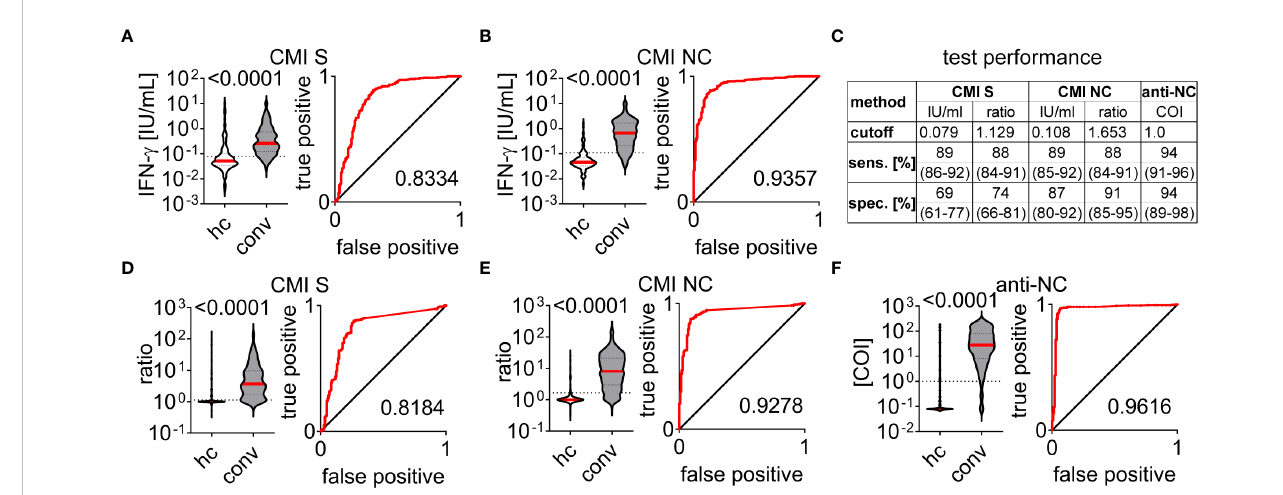
FIGURE 2 Test performance characteristics of cell-mediated immunity and antibody testing to SARS-CoV-2 Cell-mediated immunity (CMI) measured in healthy control (hc) and convalescent (conv) groups by supernatant interferon (IFN)- ɣ concentration in response to stimulation with peptide pools covering sequences of the SARS-CoV-2 (A) spike (S) or (B) nucleocapsid (NC) proteins. Ratios to respective negative controls are depicted in (D) for S- and (E) for NC- stimulated samples. (C) Test performance characteristics for CMI and antibody tests determined for cutoff values with highest Youden indices or provided by commercial manufacturer (anti-NC). Sensitivity (sens.) and speci fi city (spec.) are provided in median and interquartile range for each test application. (F) Anti-NC antibody titers provided as cutoff indices (COI). A+B, (D – F) Differences between healthy control (hc) and convalescent (conv) group were assessed by the Mann-Whitney test and p-value is provided above each diagram, dotted lines indicate corresponding cutoff value. Receiver operating characteristic curves and according area under the curve are provided for each test